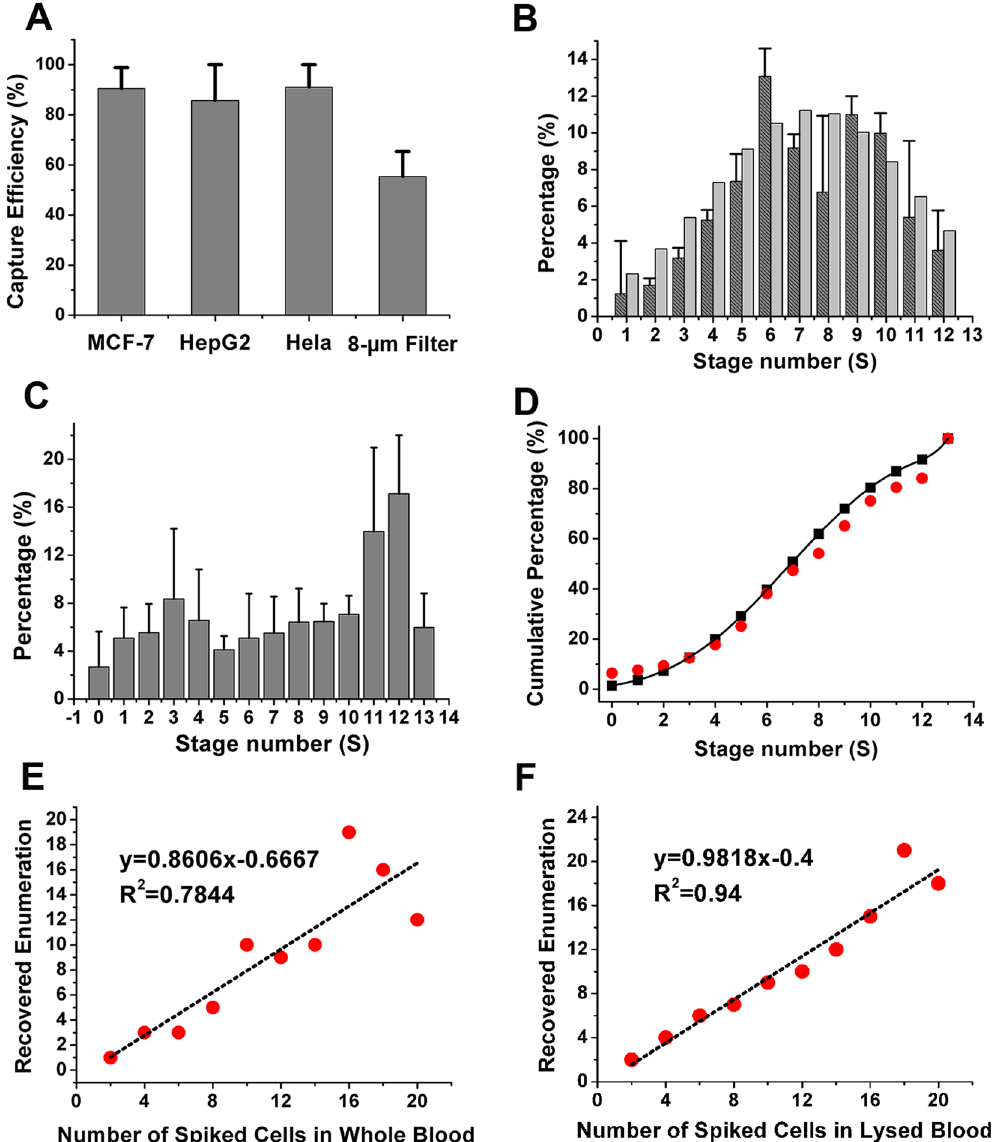
composed of square microposts with diameter of 20 µ m for a single array. ( B ) Distribution obeys Gaussian distribution with mean value of 7.3 and standard derivation of 3.54. Dark gray is experimental values and gray is calculated ones. They are pretty fit. ( C ) Cumulative percentage distribution at various stages with 0 representing inlet and 13 as outlet. Experimental values are in black and calculated values in red (flow rate 1 ml/h). ( D ) Percentage distribution for tumor cells spiked in whole blood at various stages with mean value of 7.6. ( E ) Capture efficiencies for accurate small number of spiked MCF-7 cells in whole blood. ( F ) Capture efficiencies for accurate small number of spiked MCF-7 cells in lysed